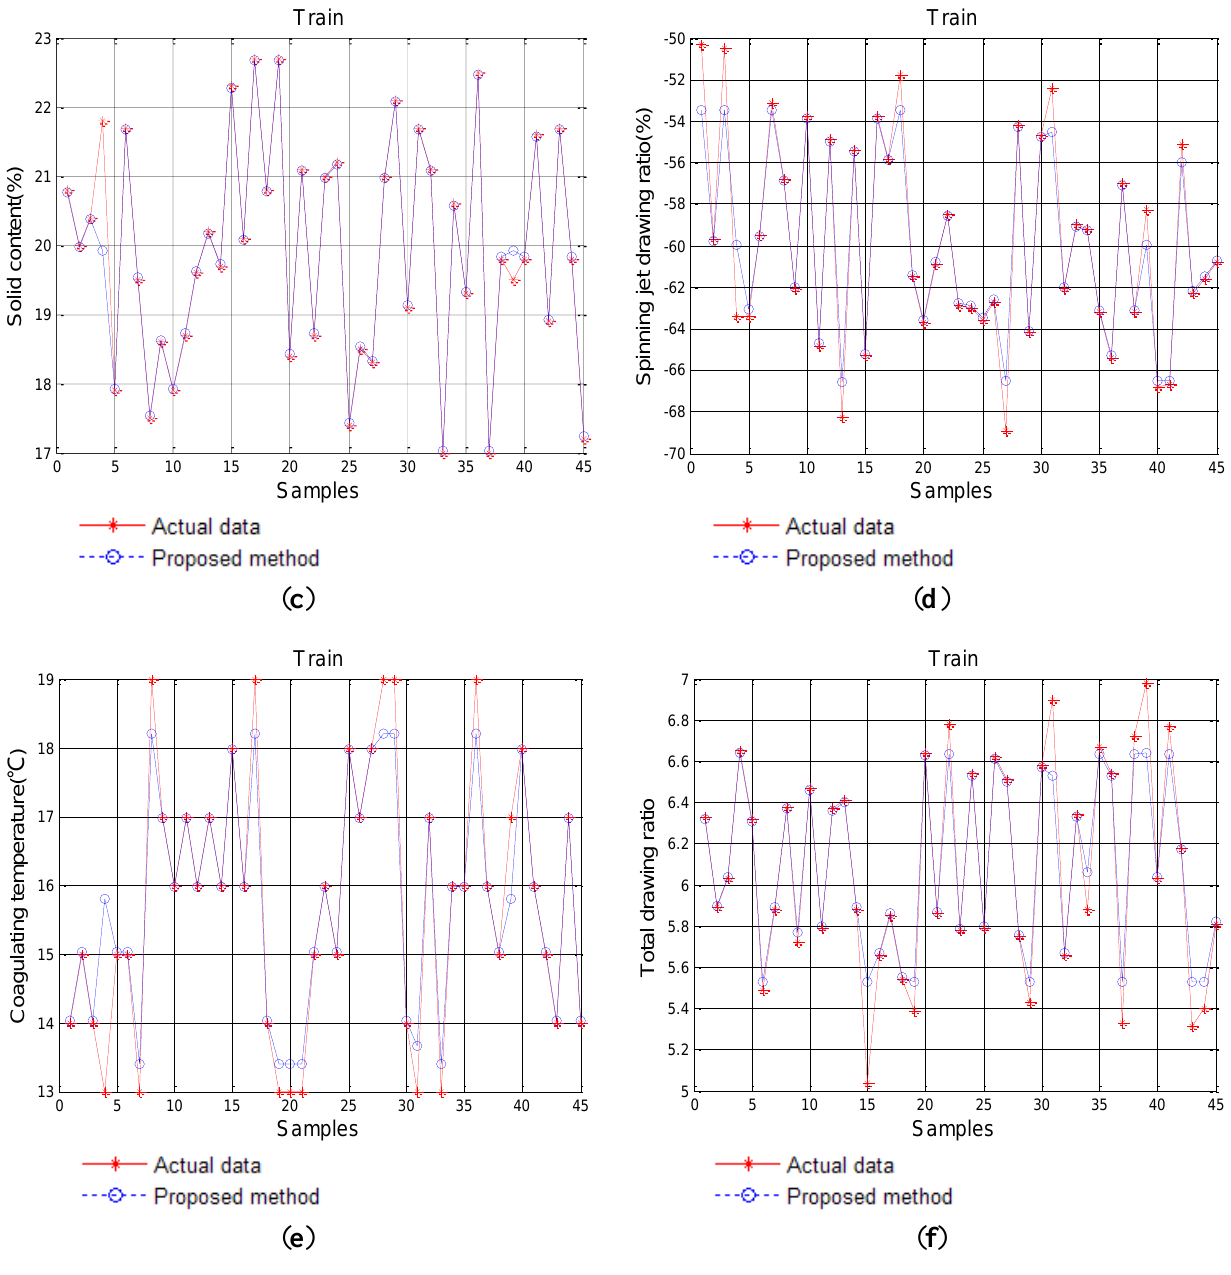
Figure 6. Training results of the proposed SVM-IPSO model. ( a ) Viscosity average molecular weight; ( b ) Conversion ratio; ( c ) Solid content; ( d ) Spinning jet drawing ratio; ( e ) Coagulating temperature; ( f ) Total drawing